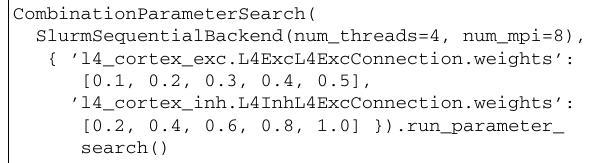
FIGURE 5 | Example of tuning curve plotting. Responses of four neurons in responses to optimally oriented drifting sine-gratings disks confined to an aperture of varying diameter (A) . Responses of the same four neurons as in (A) to optimally oriented full-field drifting